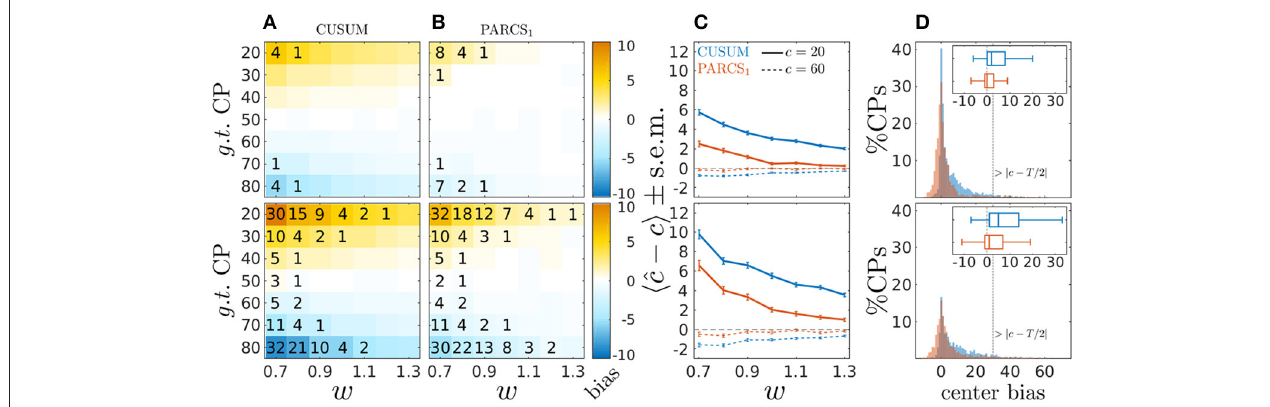
FIGURE 3 | Center bias in PARCS compared to CUSUM for temporally dependent noise with σ = 0.7 (top) and σ = 1.0 (bottom); (A,B) bias, hˆ c − c i , color-coded as indicated by the color bar; numbers indicate rounded type II error rates; (C) bias ± s.e.m. for c = 20 (solid) and c = 60 (dashed); (D) center bias distributions for c ∈ { 20,80 } and σ = 1.0; inset shows center bias distributions as boxplots that mark the median and first and third quartiles; whiskers include points within 1.5 times the interquartile range; outliers are